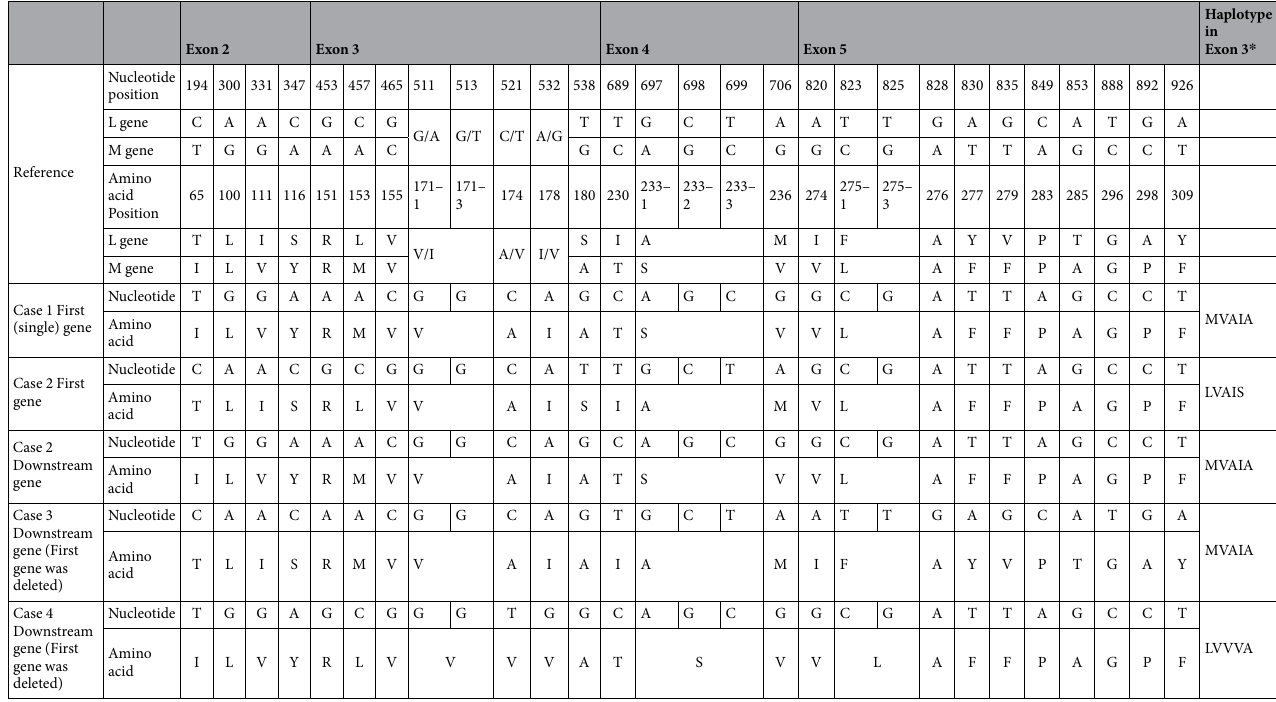
Table 1. Nucleotides in each gene of the four cases. The positions of nucleotides different between wild-type L and M genes, and polymorphic nucleotide positions 511, 513, 522 and 532 as well, are shown. * Haplotype in Exon 3 was determined by amino acid residues at 153, 171, 174, 178, and